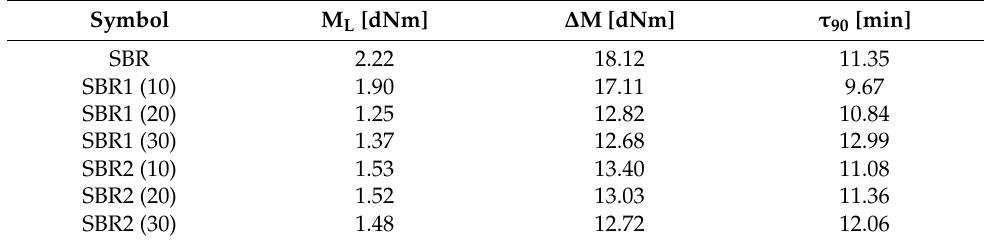
Table 3. Influence of BCA on the rheometric properties of SBR